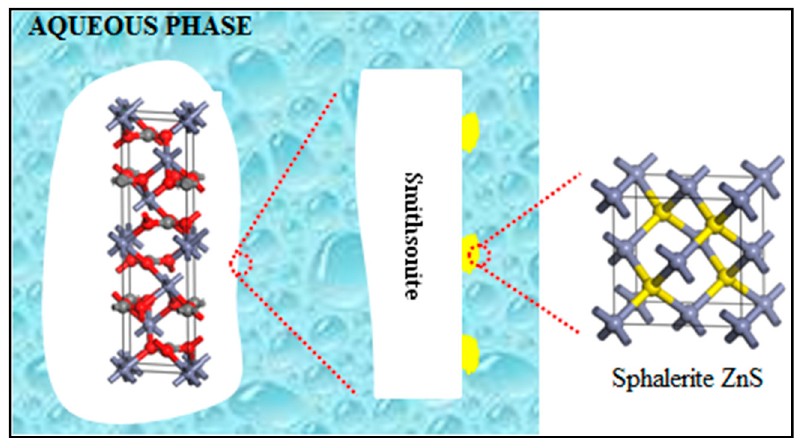
Figure 11. A model of the sulfidized smithsonite particle that shows ZnS island structures (in yellow) grown on smithsonite (in white).